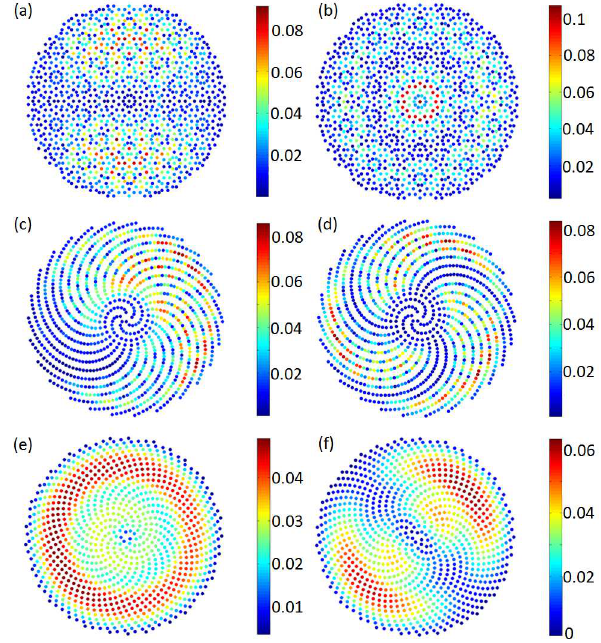
Figure 20. Examples of long-lived critical eigenvectors with small IPR for N = 1108 Penrose array with ( a ) ( Λ = − 0.9896 − 1.0865 i , IPR = 0.0029 ) ; ( b ) ( Λ = − 0.9897 − 1.1118 i , IPR = 0.0033 ) ; N = 1000 µ -spiral array with ( c ) ( Λ = − 0.9904 − 0.6844 i , IPR = 0.0021 ) ( d ) ( Λ = − 0.9911 − 0.7660 i , IPR = 0.002 ) ; N = 1000 τ -spiral array with ( e ) ( Λ = − 0.9882 + 0.9366 i , IPR = 0.0014 ) ; and ( f ) ( Λ = − 0.9876 + 0.9359 i , IPR = 0.0019 ) . The S λ 2 values are all equal to 4.19 and color-coding is the vector norm of the eigenvector component ( x , y , z ) associated with each